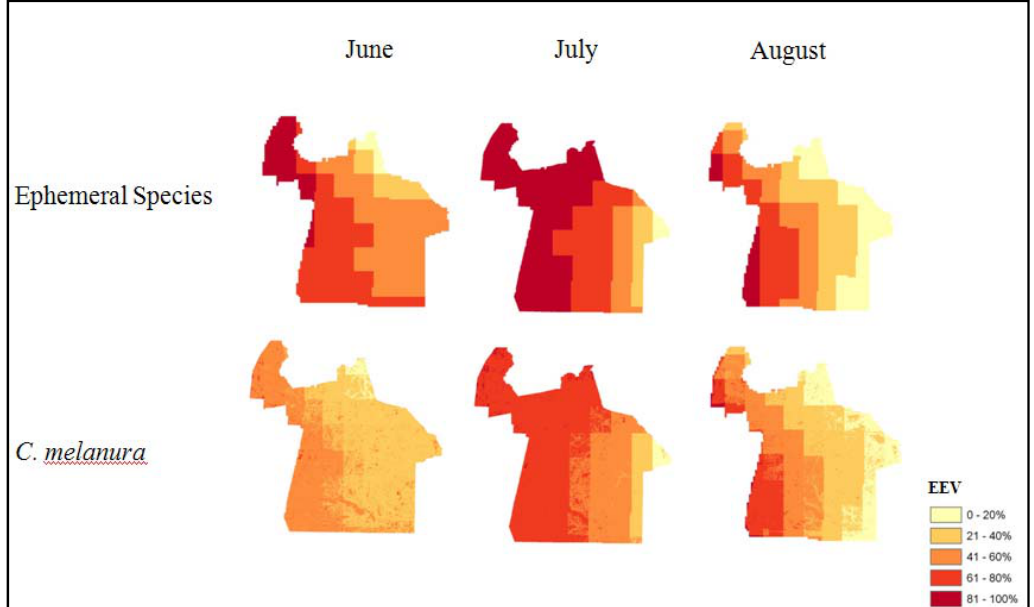
Figure 5. The effects of the environmental variables on mosquito abundance. Values were separated into five equal interval classes that represent the percent effect on